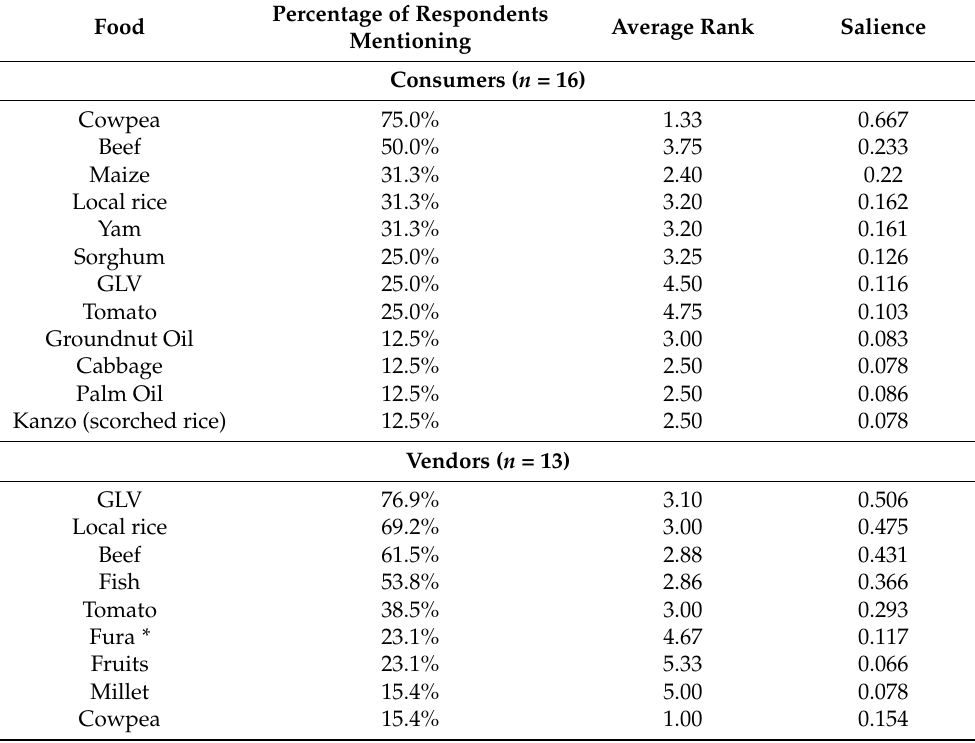
Table 3. Free-list results for “unsafe